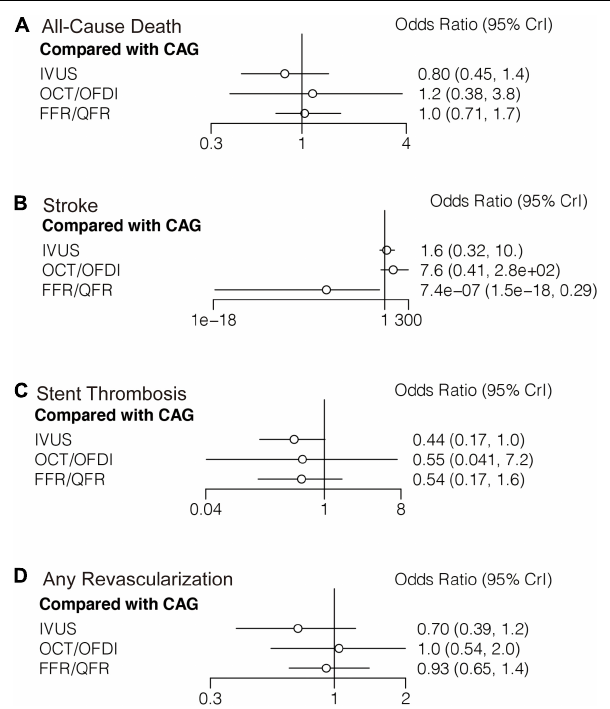
FIGURE 4 | Comparisons of secondary outcomes among guidance modalities included in the network meta-analysis. CAG, coronary angiography; FFR, fractional flow reserve; IVUS, intravascular ultrasound; OCT, optical coherence tomography; OFDI, optical frequency domain imaging; QFR, quantitative flow ratio. (A) All-cause death. (B) Stroke. (C) Stent thrombosis. (D) Any revascularization.